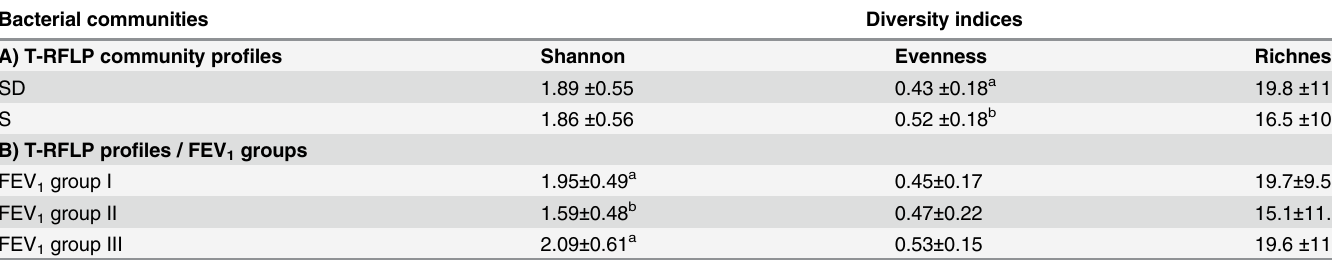
Data show the mean indices for substantial decliners (SD) and stable (S) patients ± standard deviation. Different superscript letters in a column indicate statistically signi fi cant (P < 0.05) differences after one-way ANOVA and Tukey post-hoc comparison.